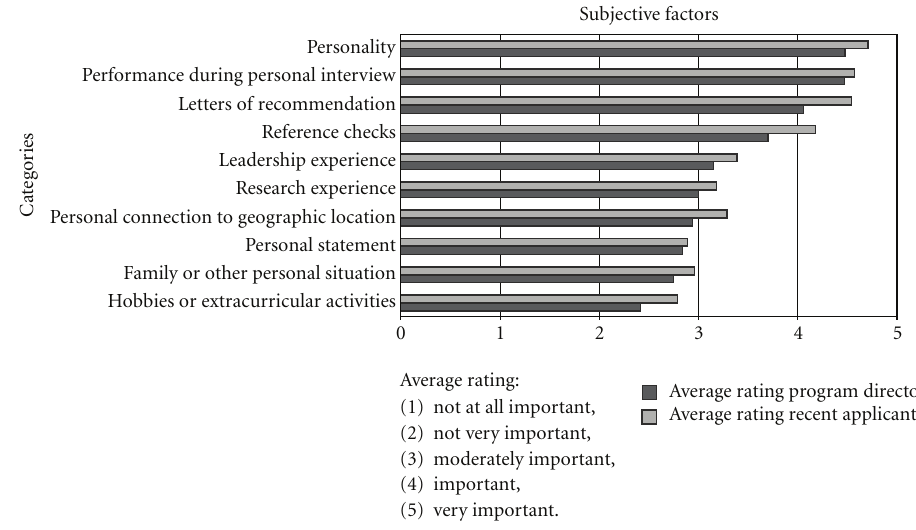
Figure 3: Bar chart comparing the importance of various subjective fellowship program selection factors between program directors and recent